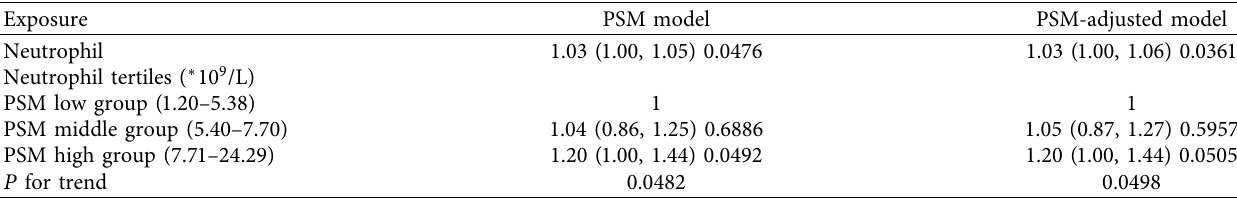
Table 7: Multivariate results by Cox regression ( N �